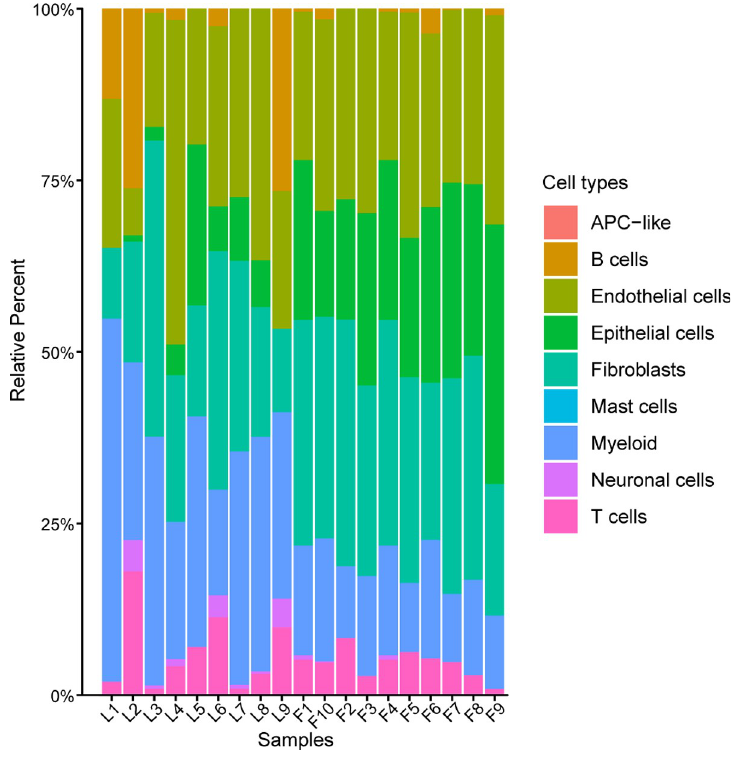
Fig 1. The proportion of 9 cell subpopulations in 9 COVID-19 and 10 control samples. The colors indicate cell type information. L1-L9, COVID-19 patients. F1-F10, control